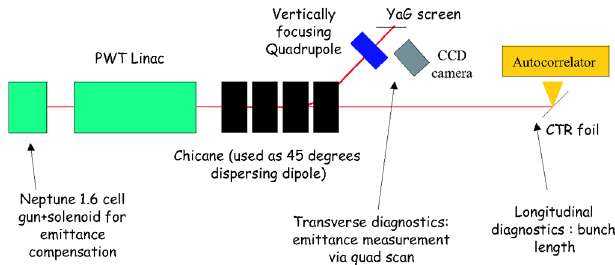
FIG. 8. (Color) Schematic layout of the Neptune ballistic bunch- ing